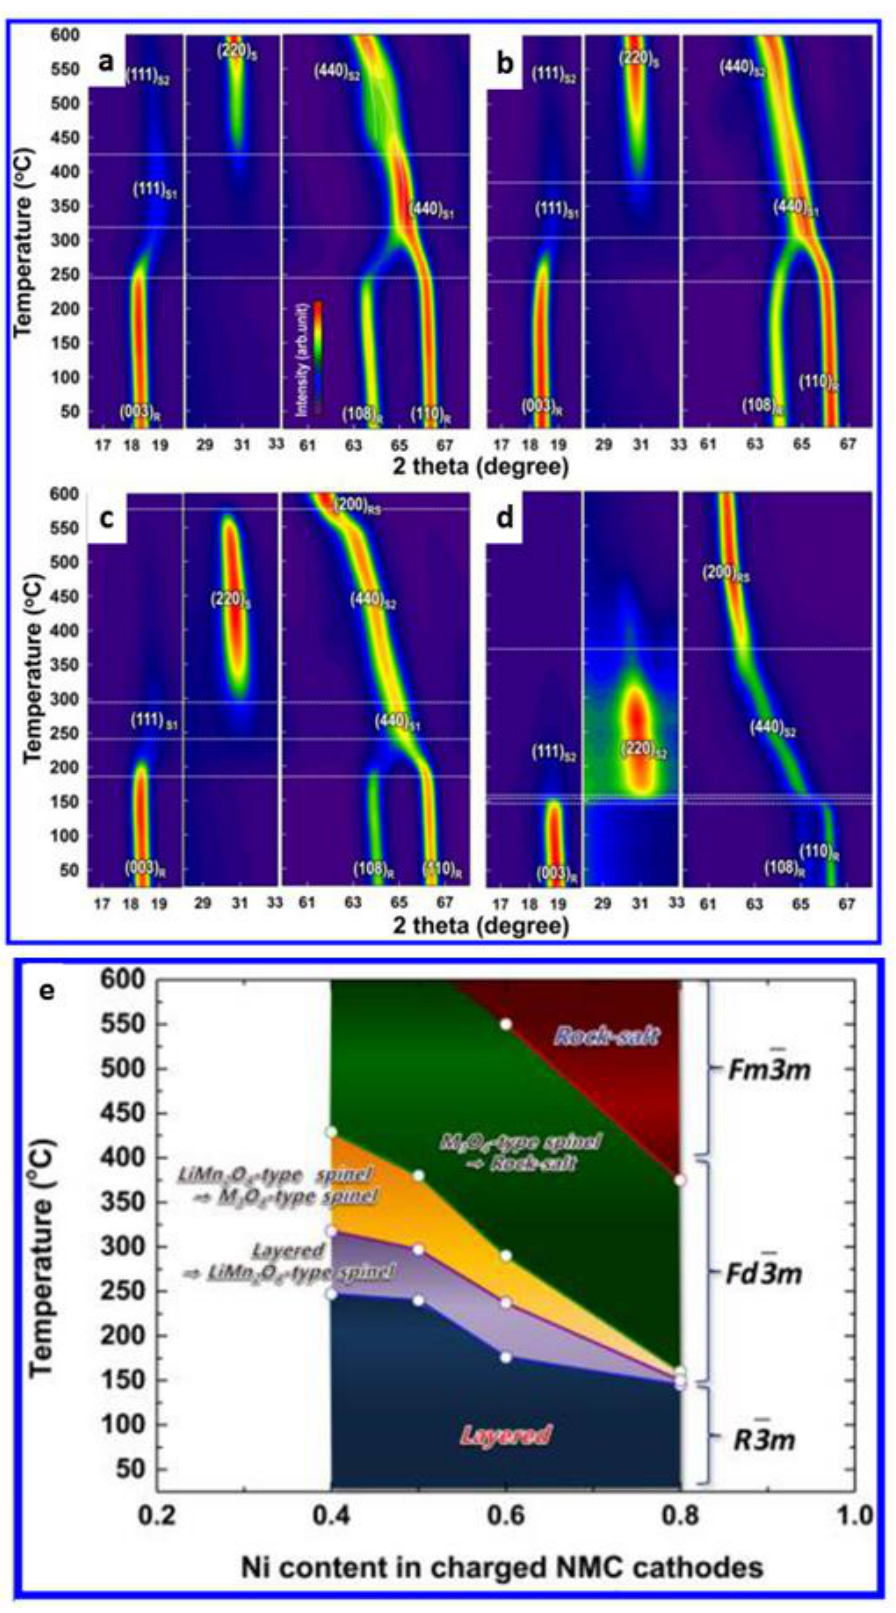
Figure 19. Image plots of XRD patterns at the selected 2 θ range for the charged ( a ) NMC433, ( b ) NMC532, ( c ) NMC622 and ( d ) NMC811. ( e ) Schematic illustration depicting the phase stability map of the charged NMC cathode during heating [93]; with permission from ACS.